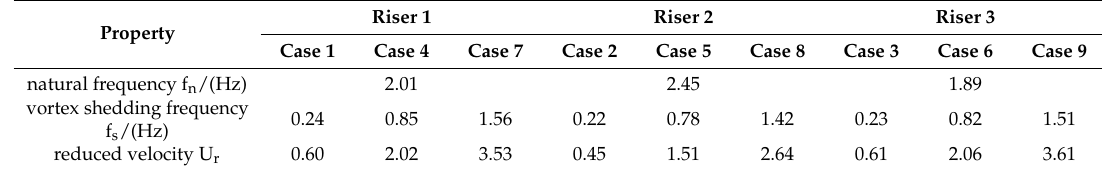
Table 6. Natural frequencies, vortex shedding frequencies and reduced velocities of the risers. Property